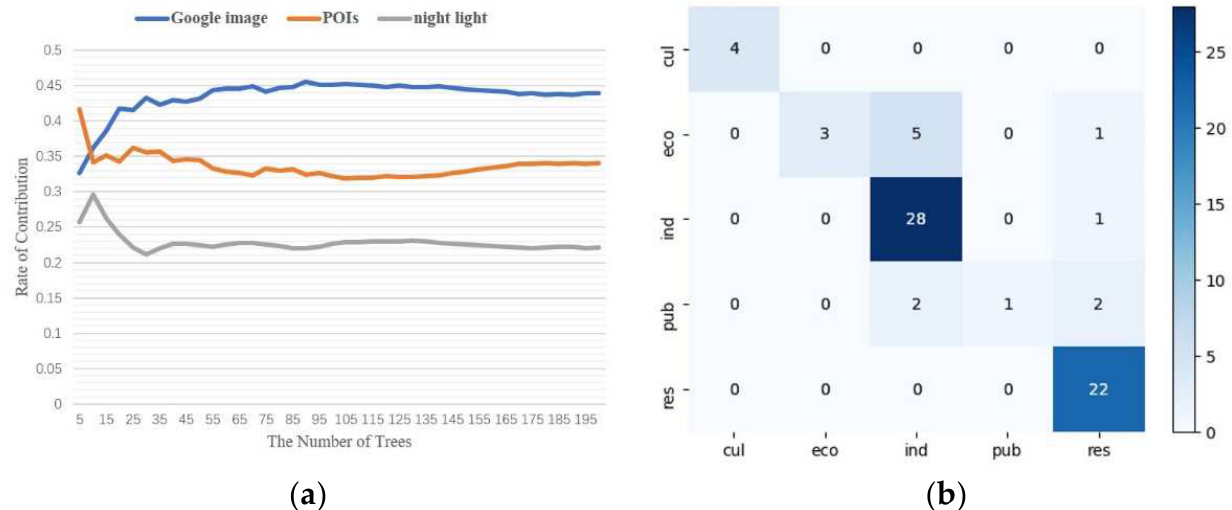
Figure 6. ( a ) Contribution rate of different data in the forecasting process. ( b ) Validation set confusion matrix .